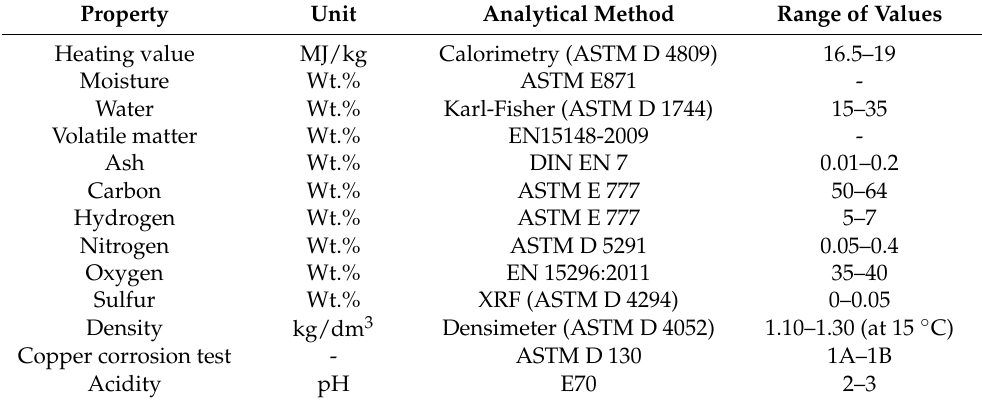
Table 6. Properties and common measurement methods of bio-oil